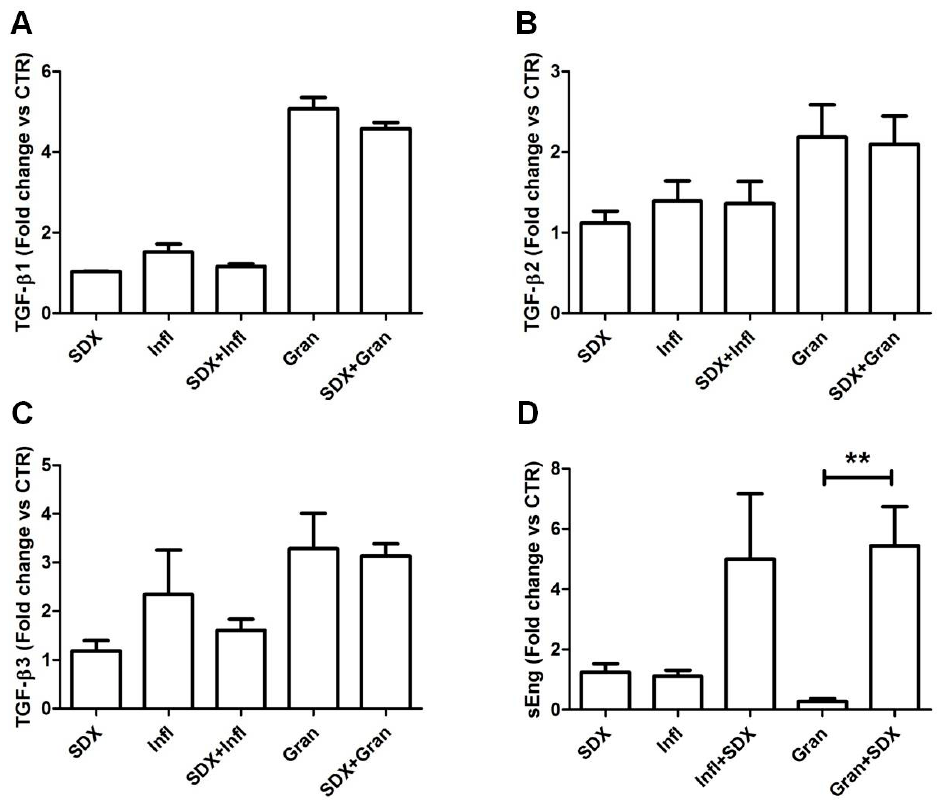
Figure 3. Concentrations of TGF- β isoforms ( A : TGF- β 1; B : TGF- β 2; C : TGF- β 3) and sEng ( D ) in culture media supernatants from WF-stimulated THP-1 cells in the presence or absence of the glycosaminoglycan sulodexide (SDX); (** = p <0.01). Statistical analyses with ANOVA followed by Dunns post hoc test.